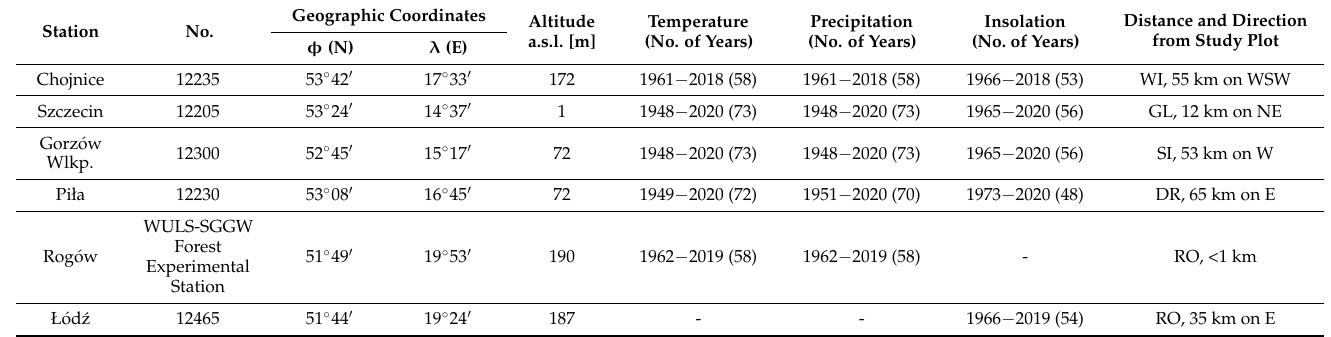
Geographic Coordinates Altitude